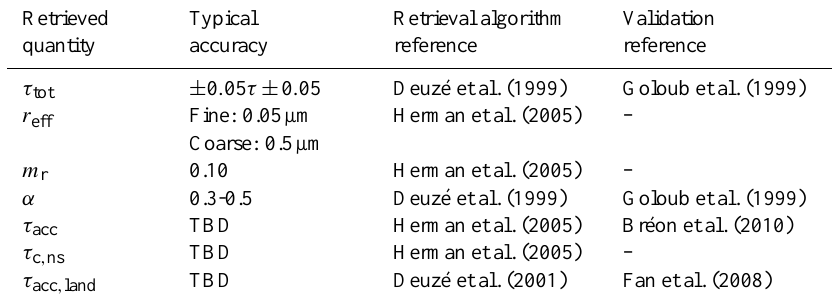
Table 1. List of the aerosol parameters currently derived from the PARASOL operational algorithms: over ocean ( τ tot = total aerosol optical depth; r eff = effective radius of the aerosol size distribution; m r = real part of the refractive index of the aerosol fine mode; α = Angstrom exponent for total aerosol optical depth; τ acc = optical depth of the aerosol fine mode; τ c , ns = optical depth for large nonspherical aerosols) and over land ( τ acc , land = optical depth of the aerosol fine mode). The spatial resolution is 18.5 × 18.5km 2 and the parameters are vertically integrated. Accuracy of some parameters is still to assess